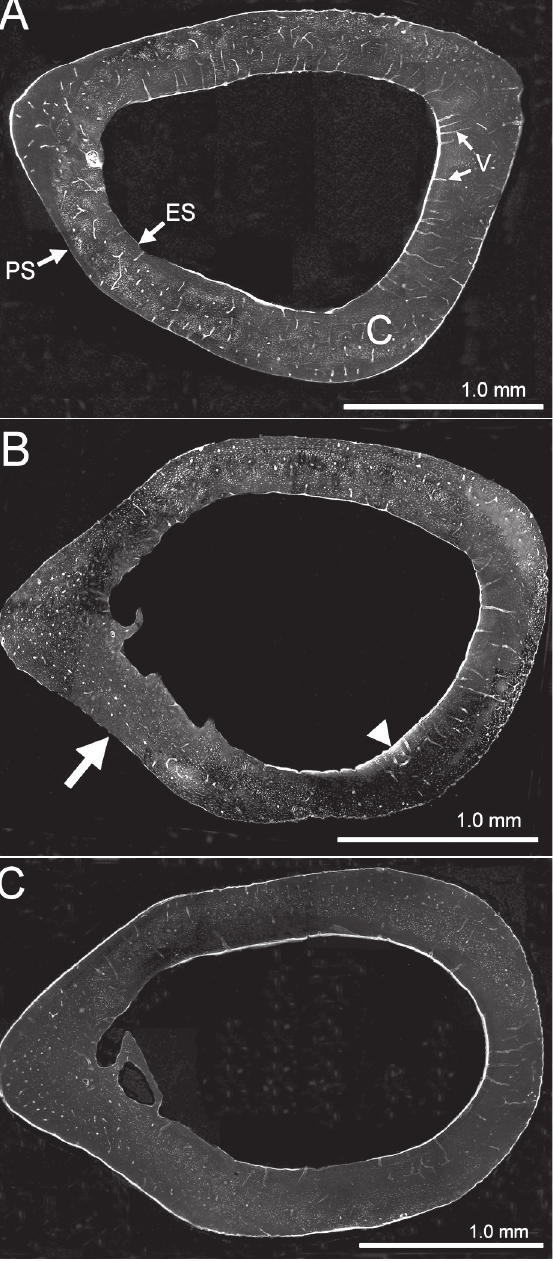
Figure 2. Cross sections of the femoral diaphysis seen under ultraviolet light, with fluorescence of the newly formed bone (clear areas) given by tetracycline labeling. A, Representative section of control I, control II, and suspended-trained animals. The periosteal (PS) and endosteal (ES) surfaces are outlined with bone fluorescence and the bone cortex (C) is traversed by vessel channels with fluorescent walls (v). B, In the suspended group, weaker subperiosteal (arrow) and endosteal (arrow head) fluorescence was observed. C, In the suspended-released ani- mals, recovery of bone formation on the periosteal and endosteal surfaces was